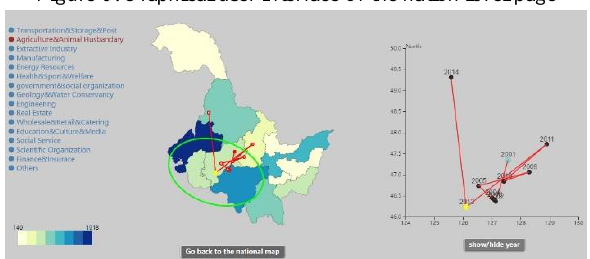
Figure 6. Graphical user interface of the nation level page